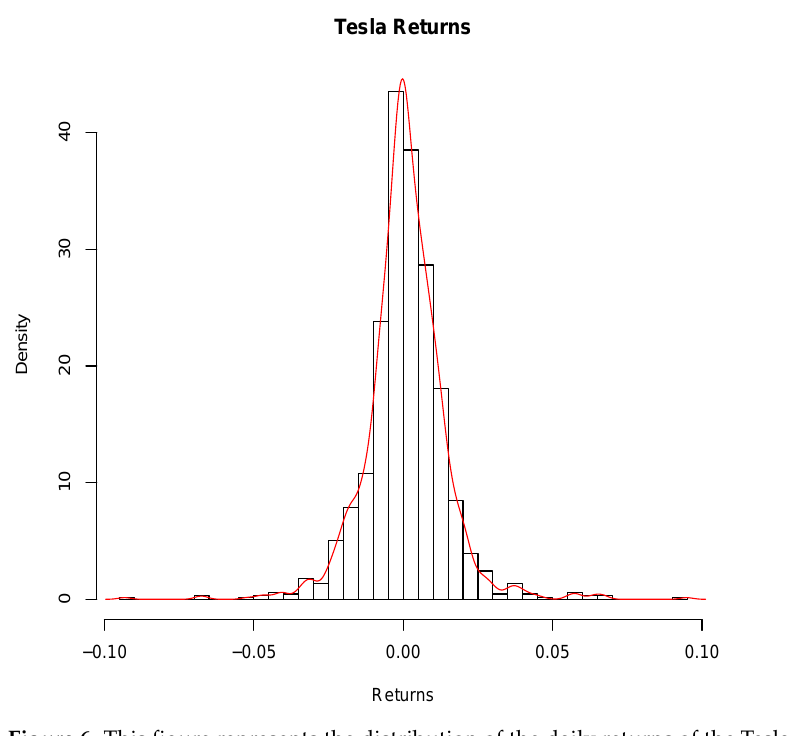
Figure 6. This figure represents the distribution of the daily returns of the Tesla share.